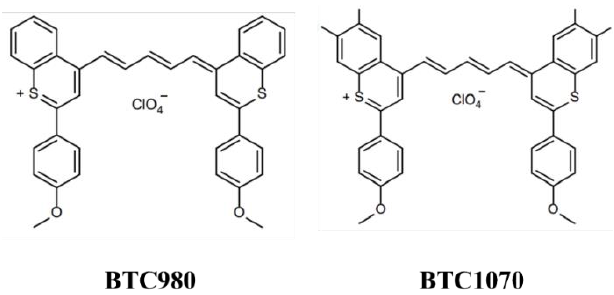
Figure 1. Chemical structures of the BTC980 and BTC1070 fluorophores.